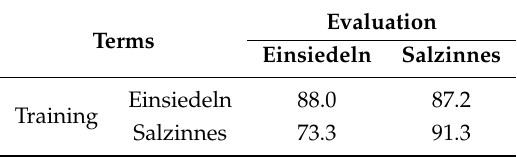
with respect to the training and evaluation manuscripts. 1